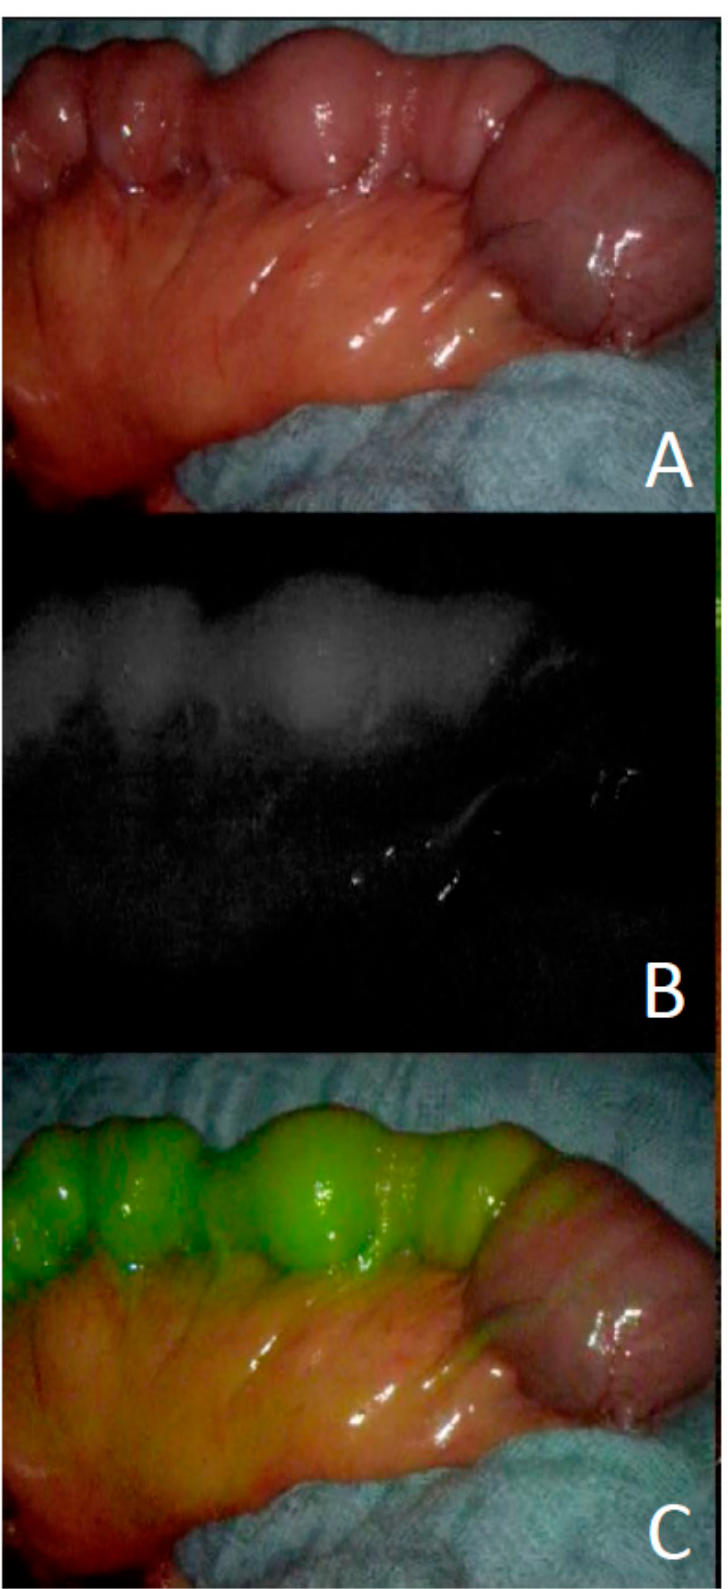
Figure 1. Intraoperative imaging using indocyanine green after isolation of a jejunum segment (( A ) native view; ( B ) ICG-Perfusion; ( C ) merged view).